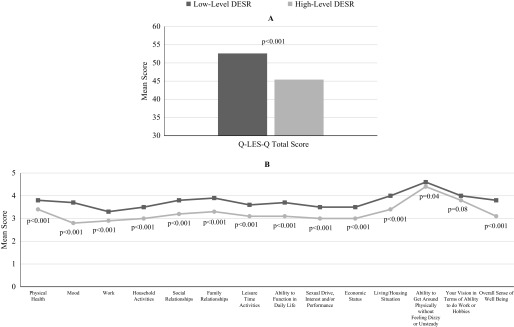
Quality of Life Enjoyment and Satisfaction Questionnaire (Q-LES-Q) scores of subjects with high (total Barkley ED score ≥ 8) and low (total Barkley ED score < 8) DESR scores. (A) Q-LES-Q mean total score and (B) Q-LES-Q individual items. Patients with high-level DESR were significantly more impaired than those with low-level DESR.